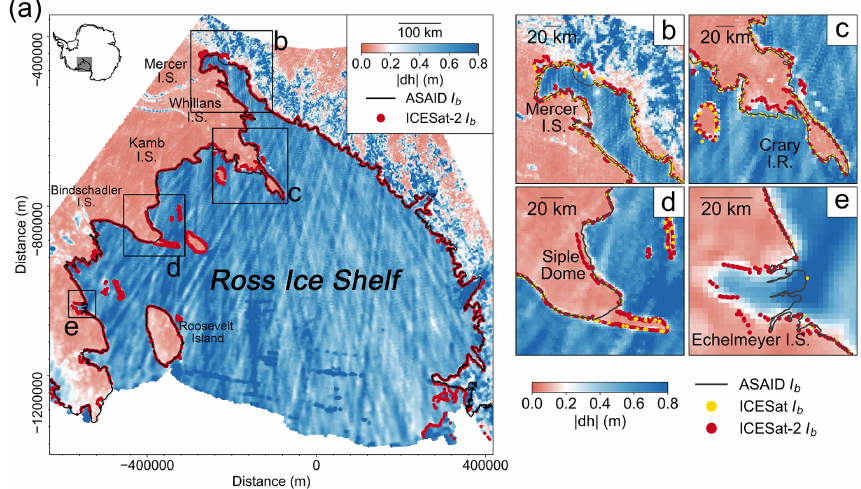
Figure A2. (a) Spatial distribution of the absolute elevation change at ICESat-2 crossovers per 2km grid cell across the Ross Ice Shelf overlaid with ICESat-2-derived break in slope (Point I b ); the four black boxes denote the individual regions plotted in (b) – (e) . (b) Mercer Ice Stream, (c) Crary Ice Rise, (d) Siple Dome, (e) Echelmeyer Ice Stream. In all subplots, the ICESat-2-derived breaks in slope (Point I b ) are shown as red dots. The ICESat-derived Point I b locations are shown as the yellow dots. The ASAID Point I b is shown as the black line (Bindschadler et al.,